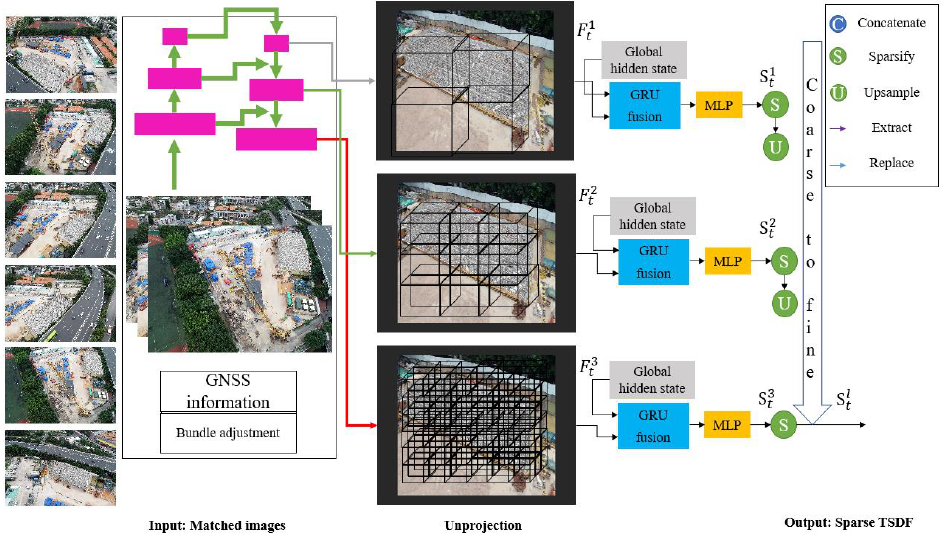
Figure 5. NeuralRecon structure.